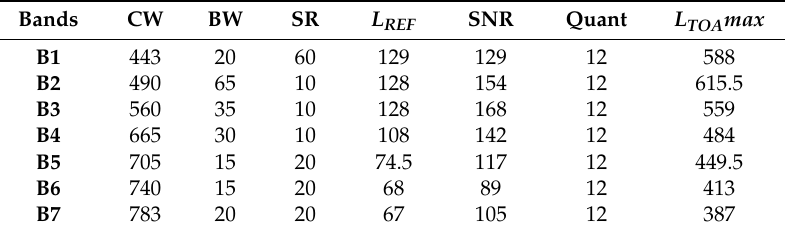
Table 2. MSI/Sentinel-2 sensor configurations used as the input for simulation. CW is the central wavelength (nm), BW is the band width (nm), SR is the Spatial Resolution (m), L REF (W · m − 2 · sr − 1 · µ m − 1 ) is the radiance in which the SNR was calculated, Quant is the quantization,